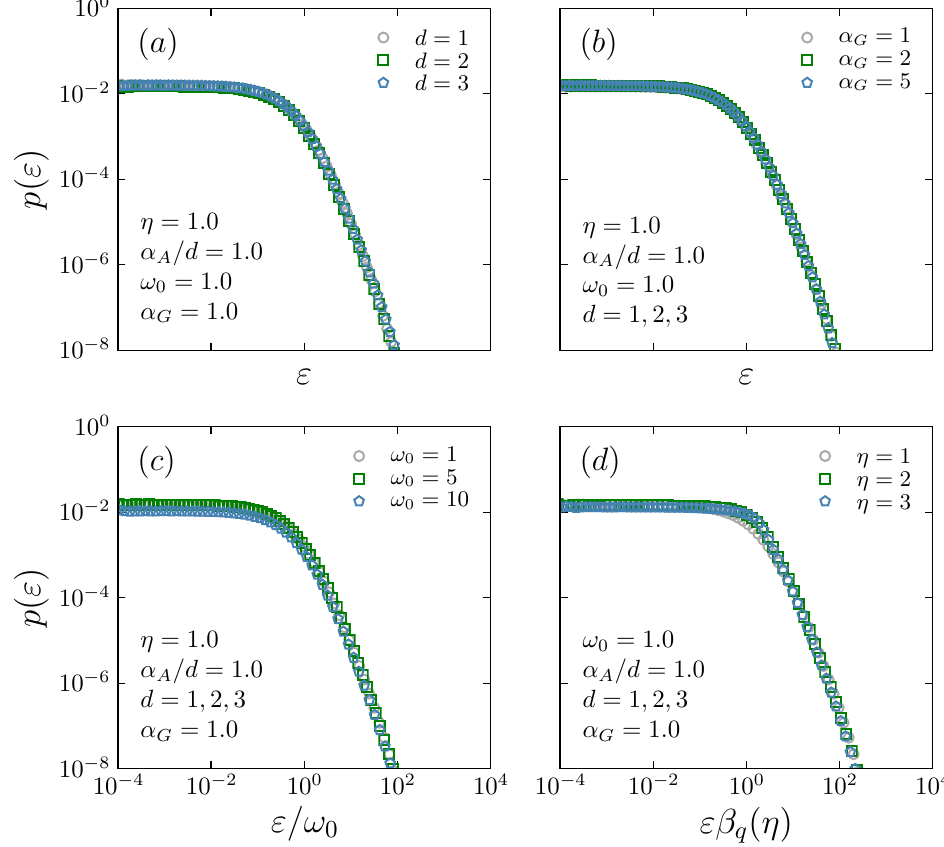
Figure 2. In these plots we show p (ε) for typical values of d ( a ), α G ( b ), w 0 ( c ) and η ( d ). ( a ) By fixing (α G , η , w 0 , α A / d ) = ( 1, 1, 1, 1 ) the dimensionality d does not modify p (ε) . ( b ) By fixing (η , w 0 , α A / d ) = ( 1, 1, 1 ) ,